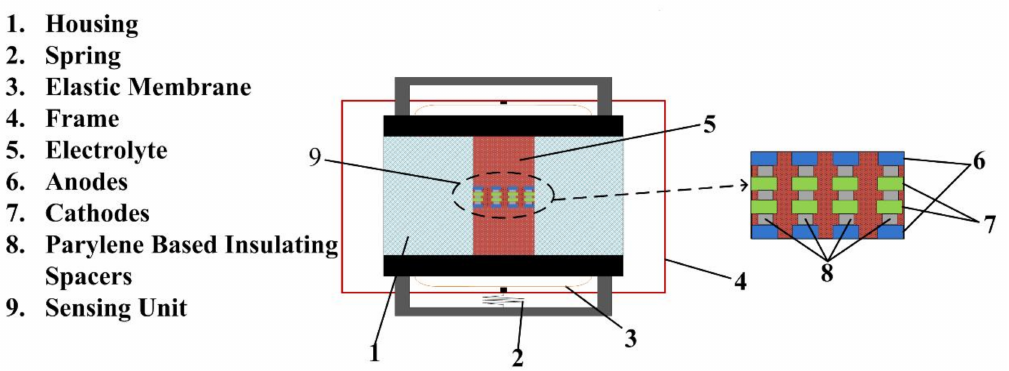
Figure 1. The schematic of the parylene-based MEMS electrochemical seismic sensor is composed of a sensing unit including porous sensing electrodes immersed in an electrolyte solution sealed in a plexiglass house by elastic membranes. In response to external seismic signals, the electrolyte moves in an opposite direction to the external vibration, leading to ion concentration gradients and raw current outputs between the anode-cathode pairs. The sensitivity of the micro-fabricated electrochemical seismic sensors was enhanced due to the decreasing of the insulating spacers, which was realized by using the parylene substrates instead of the silicon